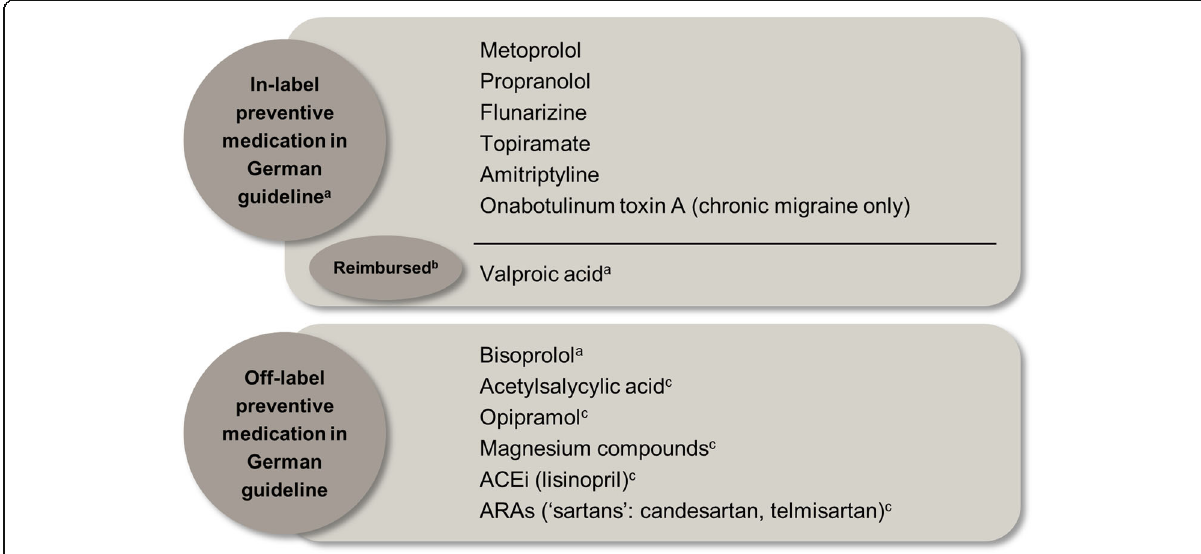
Fig. 1 Preventive medication according to the German guideline for migraine [8]. a Preventive medication(s) with good evidence. b Off-label, but may be prescribed at the expense of the German Health Care System (Social Health Insurance) pursuant to Annex VI, Section K of the German medicinal product directive. c Preventive medication with lower evidence. In the current analyses, Group 1 preventive medications are in-label preventive medications plus valproic acid; Group 2 preventive medications are all preventive treatments according to the German guideline for migraine (in- and off-label). ACEi angiotensin-converting enzyme inhibitor; ARA angiotensin II receptor